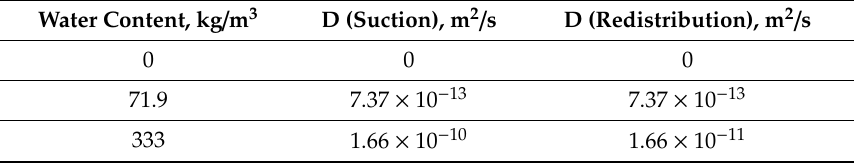
Table A16. Liquid transport coe ffi cient—improved